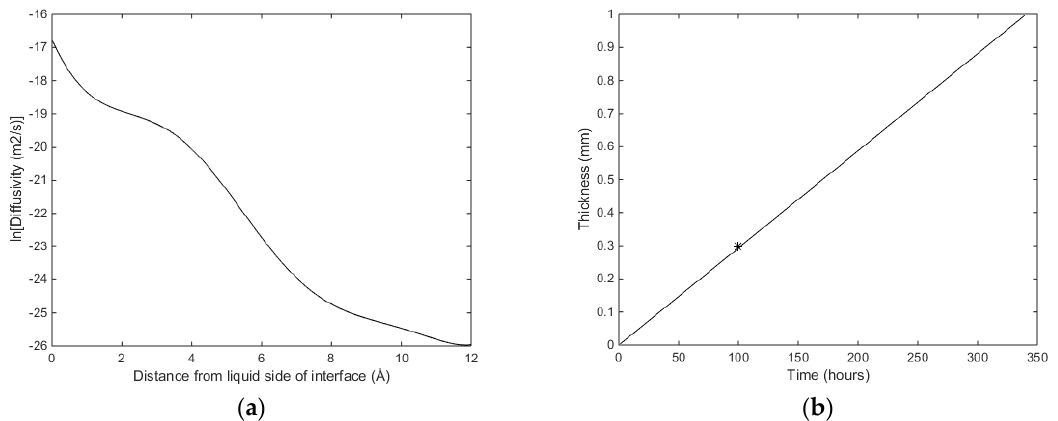
Figure 4. ( a ) Diffusivity profile for D liq = 5·10 − 08 m 2 /s in Equation (16) as applied for CH 4 hydrate. ( b ) Calculated hydrate film thickness as function of time (solid) and experimental observation from Magnetic Resonance Imaging (MRI) experiment [29,30] for CH 4 hydrate based on a resolution of 300 micron.